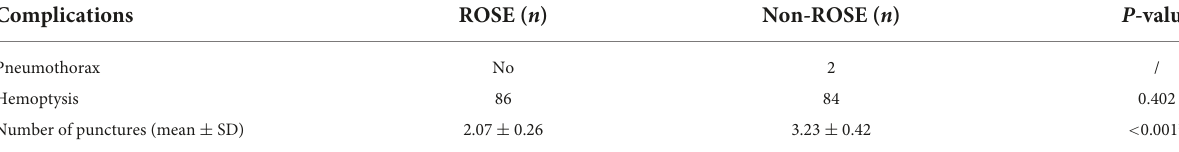
TABLE 4 Comparison of complications between ROSE and non-ROSE